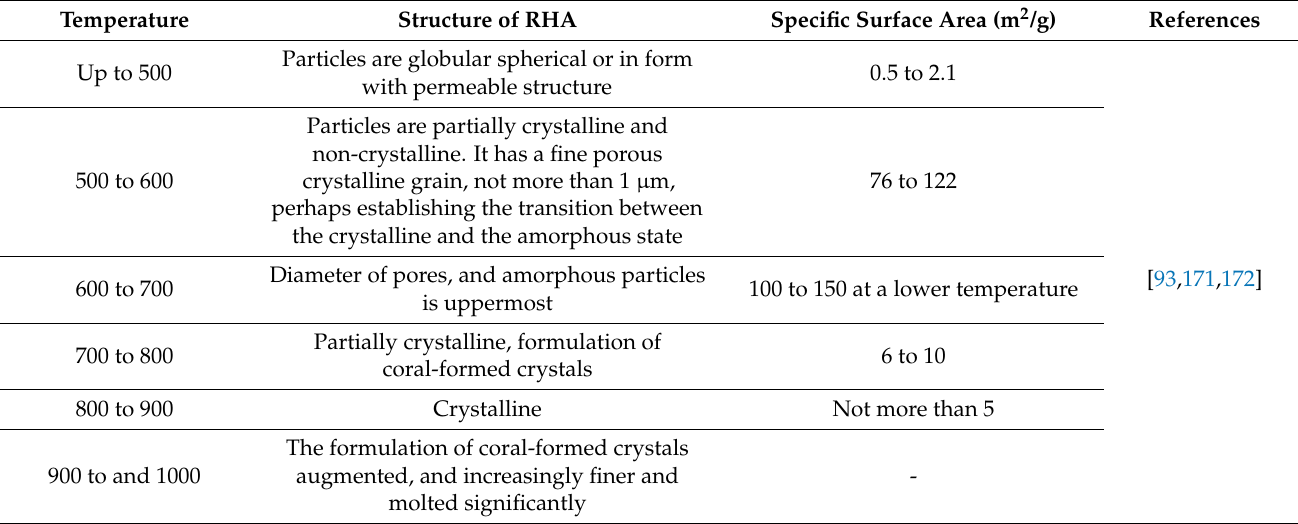
Table 8. Influence of the temperature of burning on the RHA structure.